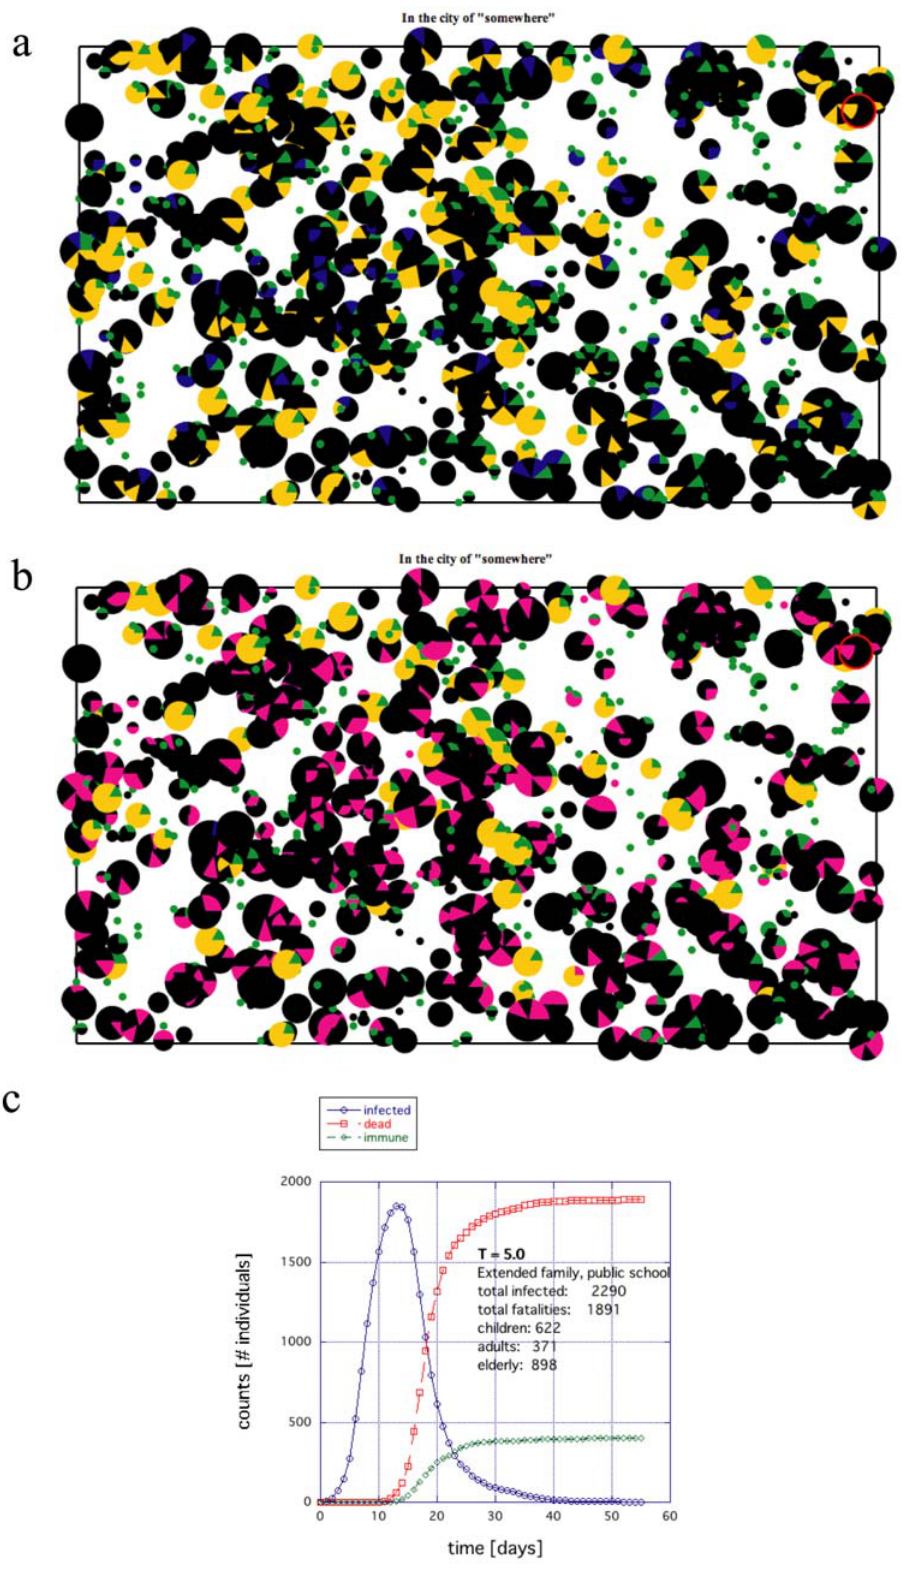
Figure 6. An example of the death toll for an extended family society, where the children go to public schools. In the extended family, the E/Rs are distributed with the families rather than grouping together in small communities. (a) Surviving population whether infected or not where black indicates deceased. (b) Population of infected individuals both deceased (black) and recovered (magenta). (c) Time histogram of the rate of infection, death and recovery.